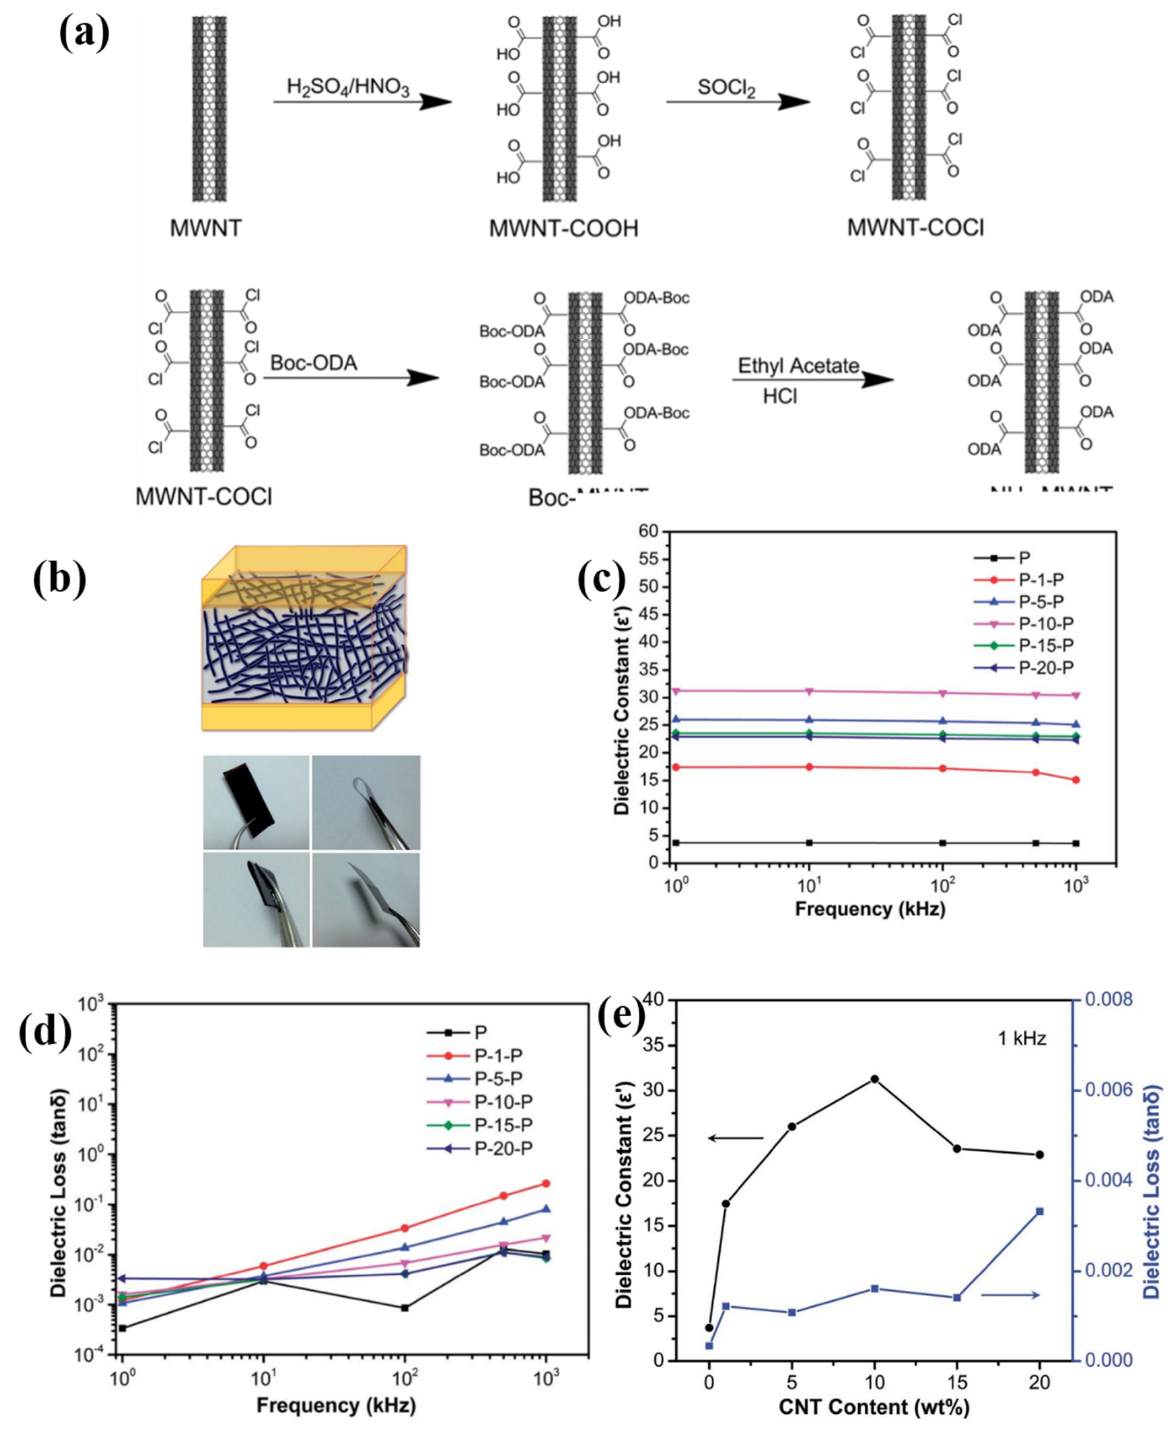
Figure 5. ( a ) Synthetic route of NH 2 -MWNT. ( b ) Schematic and physical diagram of NH 2 -MWNT/PI composites. ( c ) Dielectric permittivity and ( d ) dielectric loss of NH 2 -MWNT/PI composite films. ( e ) The dielectric properties of the composites at 1KHz influenced by the NH 2 -MWNT content. Adapted with permission [81]. Copyright 2014, Royal Society of Chemistry.